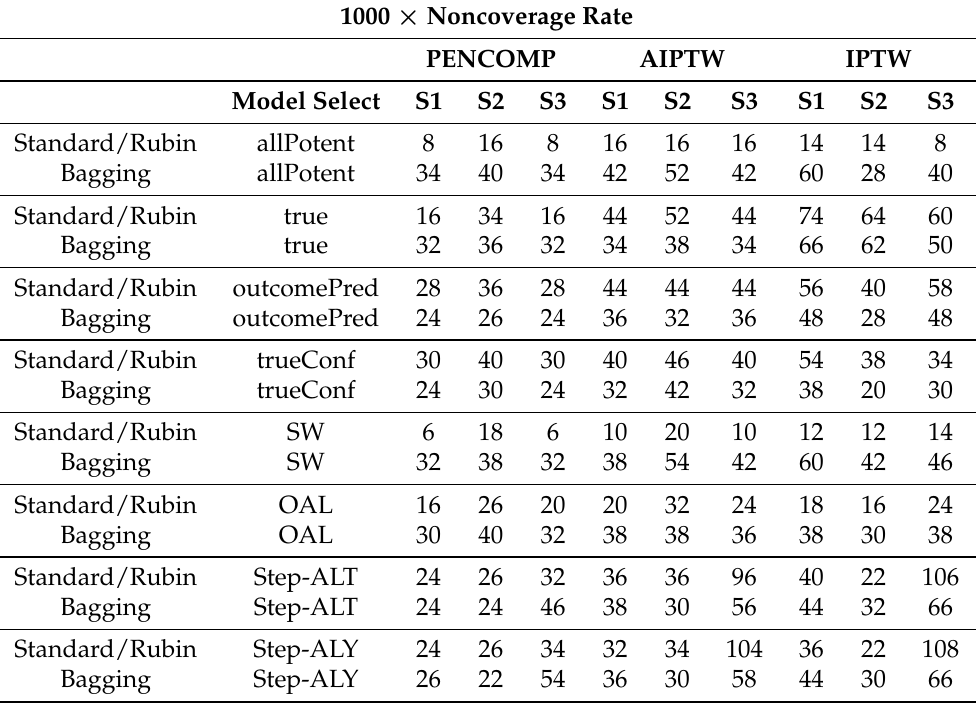
Table 2. 1000 × noncoverage rate (5%) with sample size of 200. The nominal coverage is 95%.